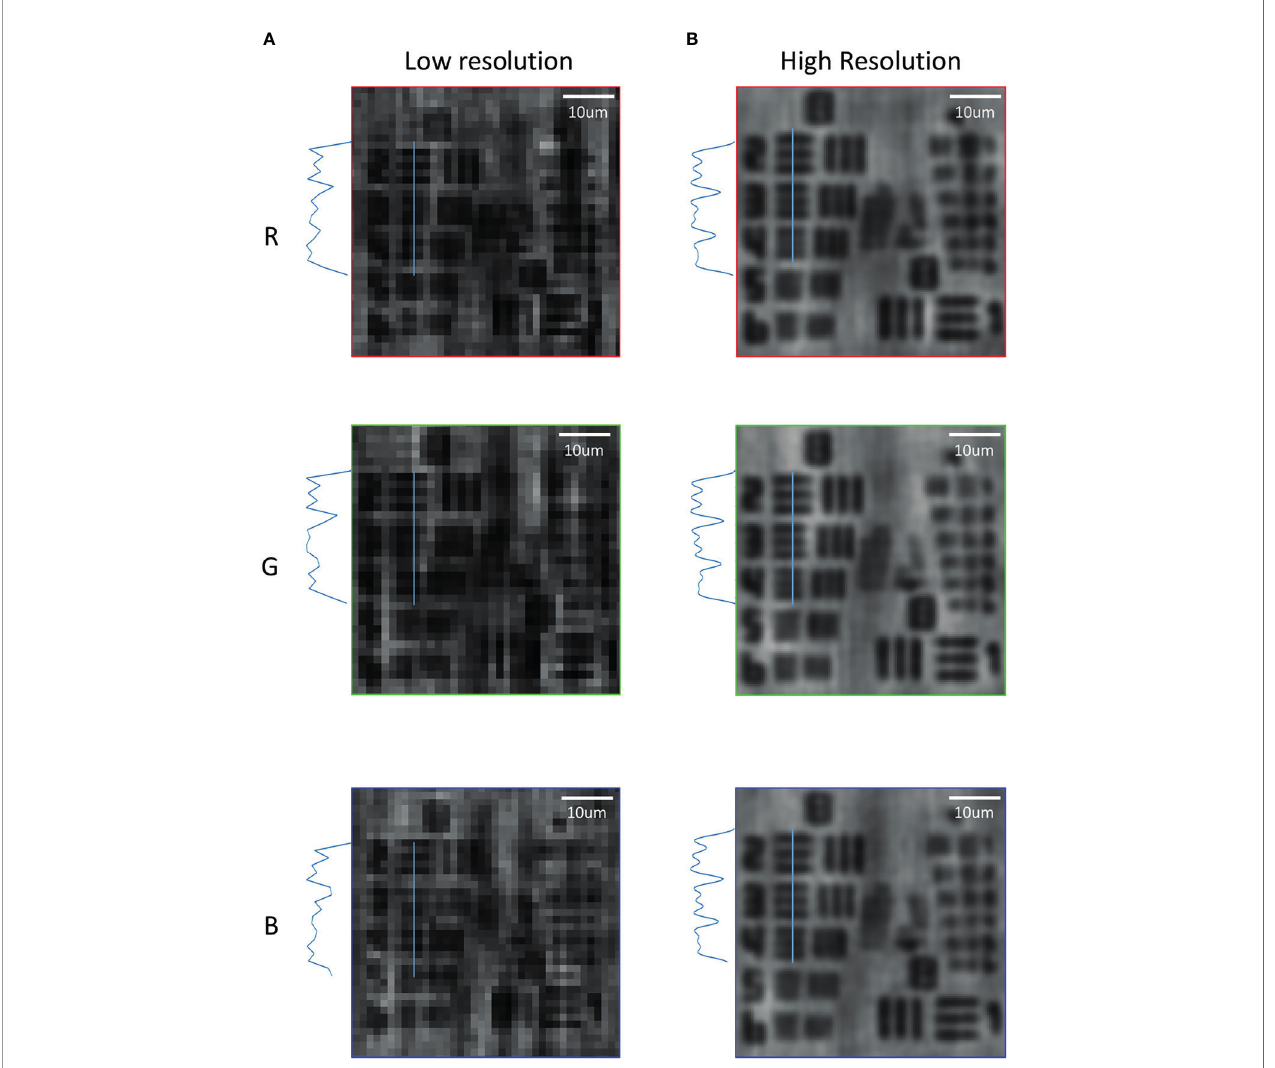
FIGURE 3 | Comparison of the pixel super-resolution and low resolution in the bands of R, G and B on the USAF1951 resolution test chart. (A) Low-resolution reconstructed images in R, G and B bands. (B) High-resolution reconstructed images in R, G and B bands by the wavelength scanning